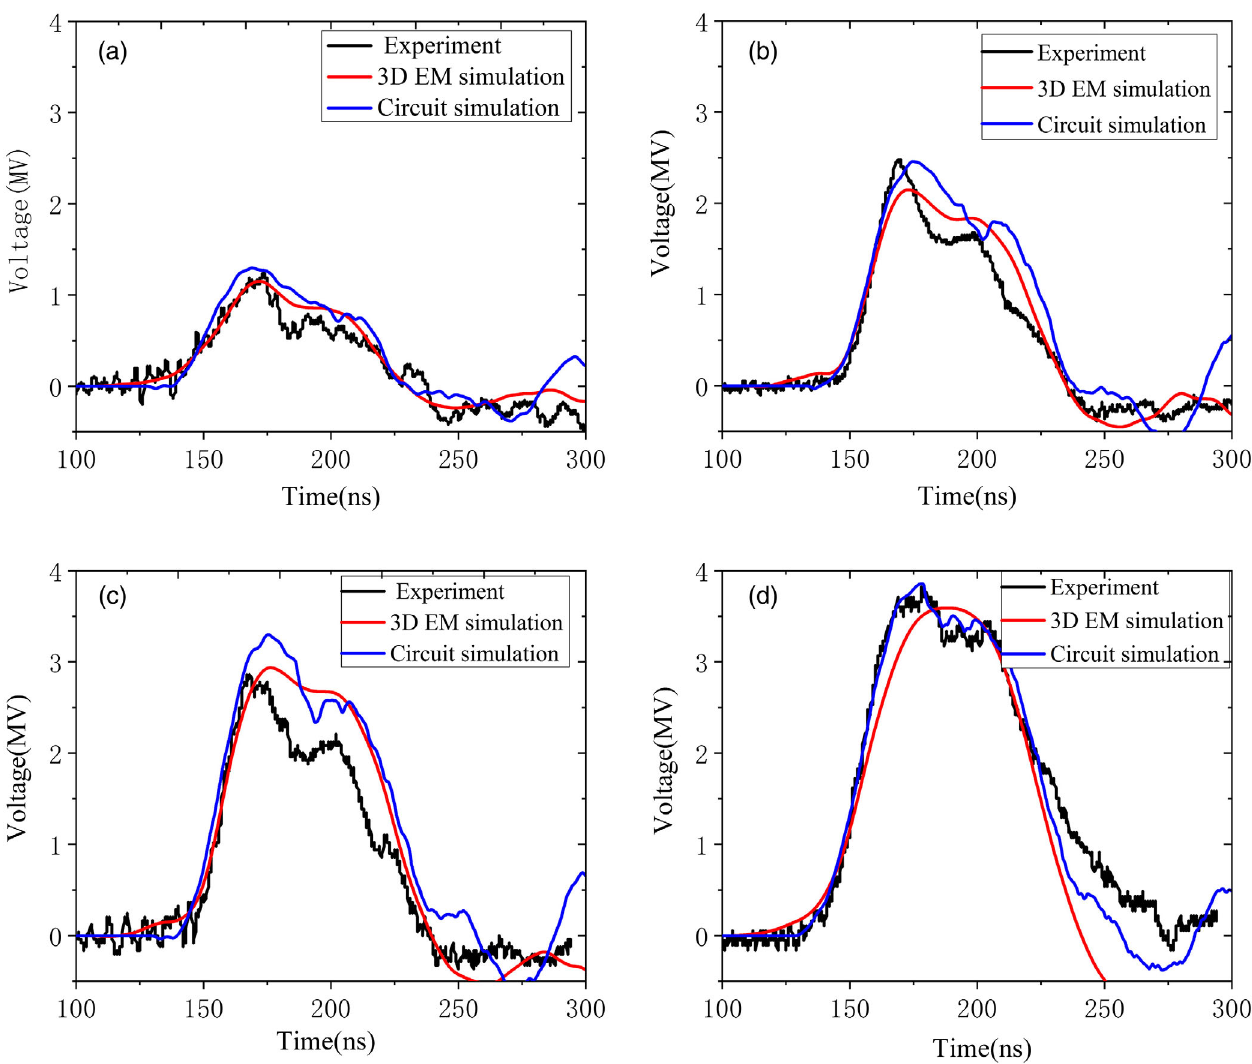
FIG. 5. Comparisons of 3D EM (red curves), circuit simulation (blue curves), and shot 19-007 (black curves). The voltages were monitored downstream of each cavity labeled in Fig. 1(b). The two Marx generators were charged to (cid:1) 50 kV.